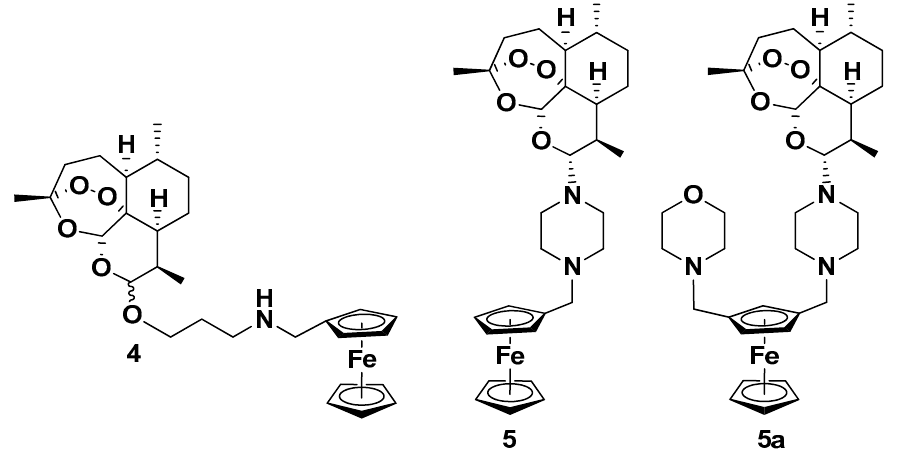
Figure 2. Artemisinin ferrocene derivatives with alkyl amine ( 4 ) and piperazine ( 5 ), ( 5a ) linkers. Table 1. In vitro antimalarial activity of hybrid 4 and parent compounds against P. falciparum strains; data from [41].